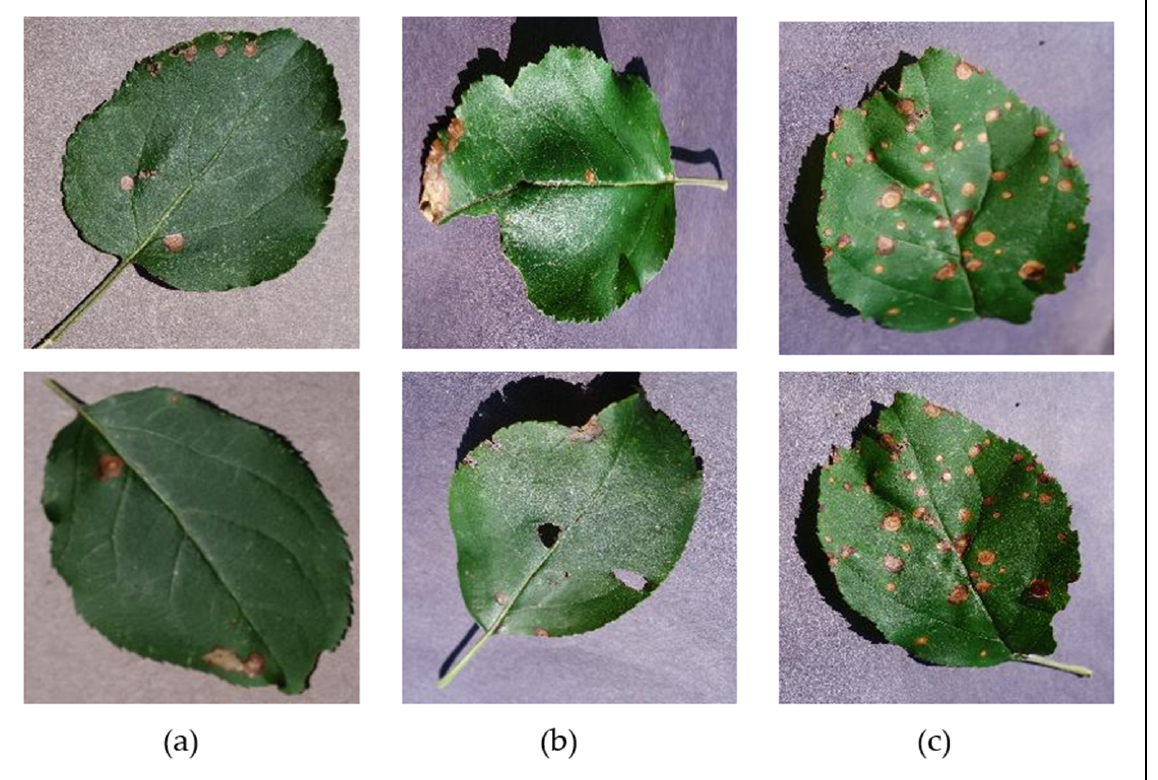
Figure 4. Examples of some of the different leaf states represented in the dataset, shown for the “ Apple Black Rot ” class—( a ) early symptoms, on a flat, complete leaf; ( b ) moderate symptoms, on a slightly distressed leaf; ( c ) severe symptoms, on a slightly bent, complete leaf.